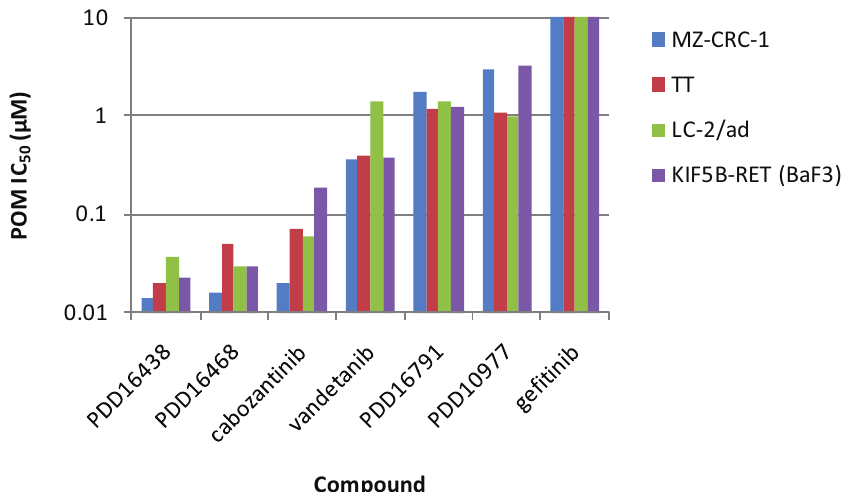
Supplementary Figure 1. Comparison of POM IC two independent measurements. IC